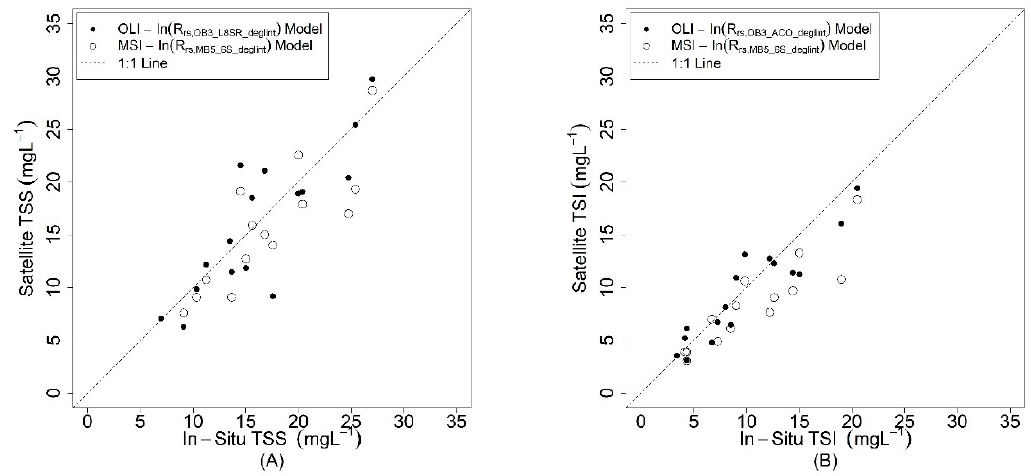
Figure 12. The scatter plots with in situ TSS ( A ) and TSI ( B ) values with satellite TSS and TSI estimates for both OLI (Fill circles) and MSI (empty circles).